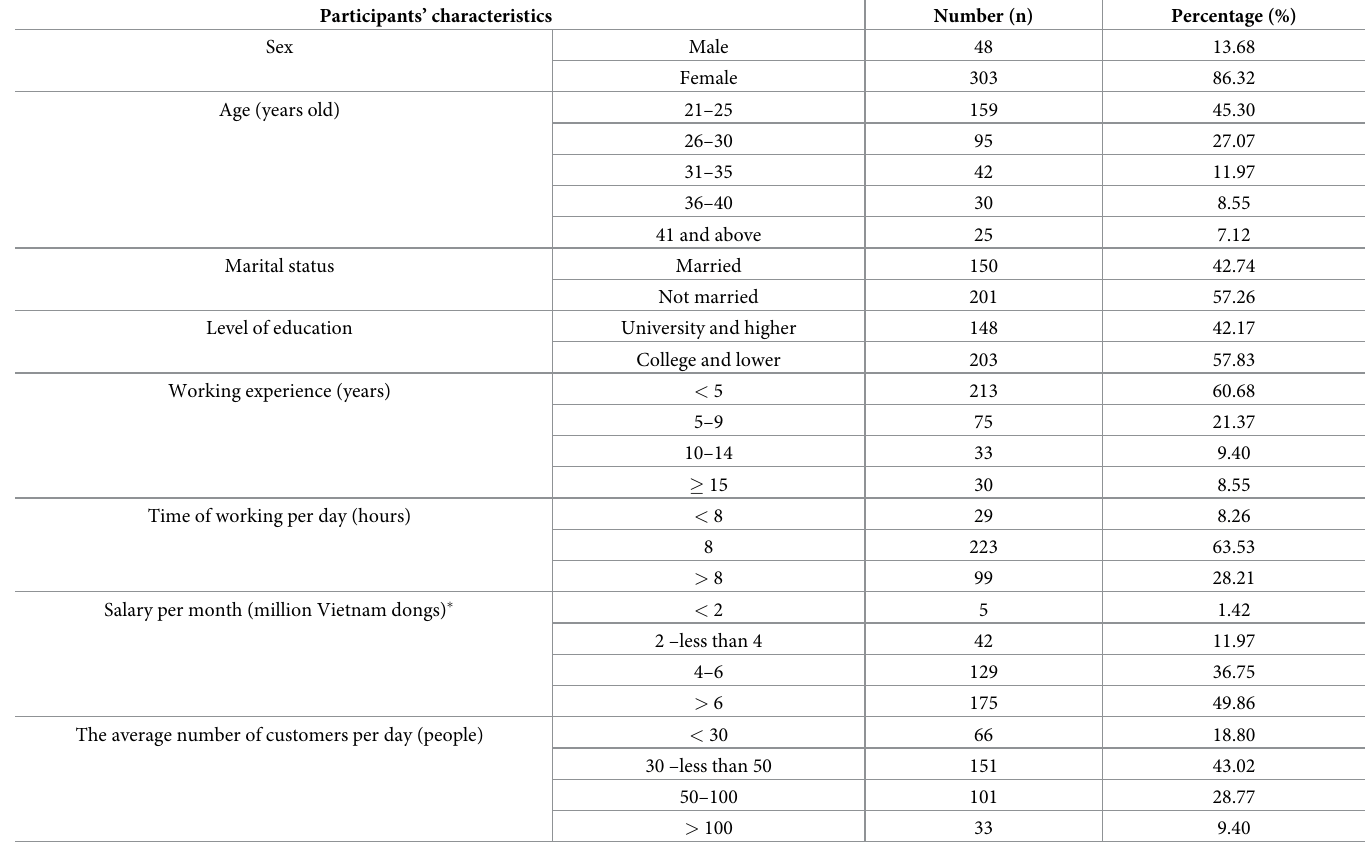
Table 2. Participants’ characteristics (N = 351